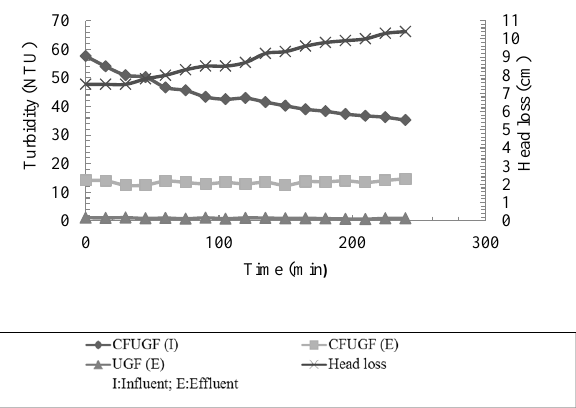
Figure 8.Turbidity in CF-UGF and UGF units and head loss on CF-UGF 3 Figure 8. Turbidity in CF-UGF and UGF units and head loss on CF-UGF.